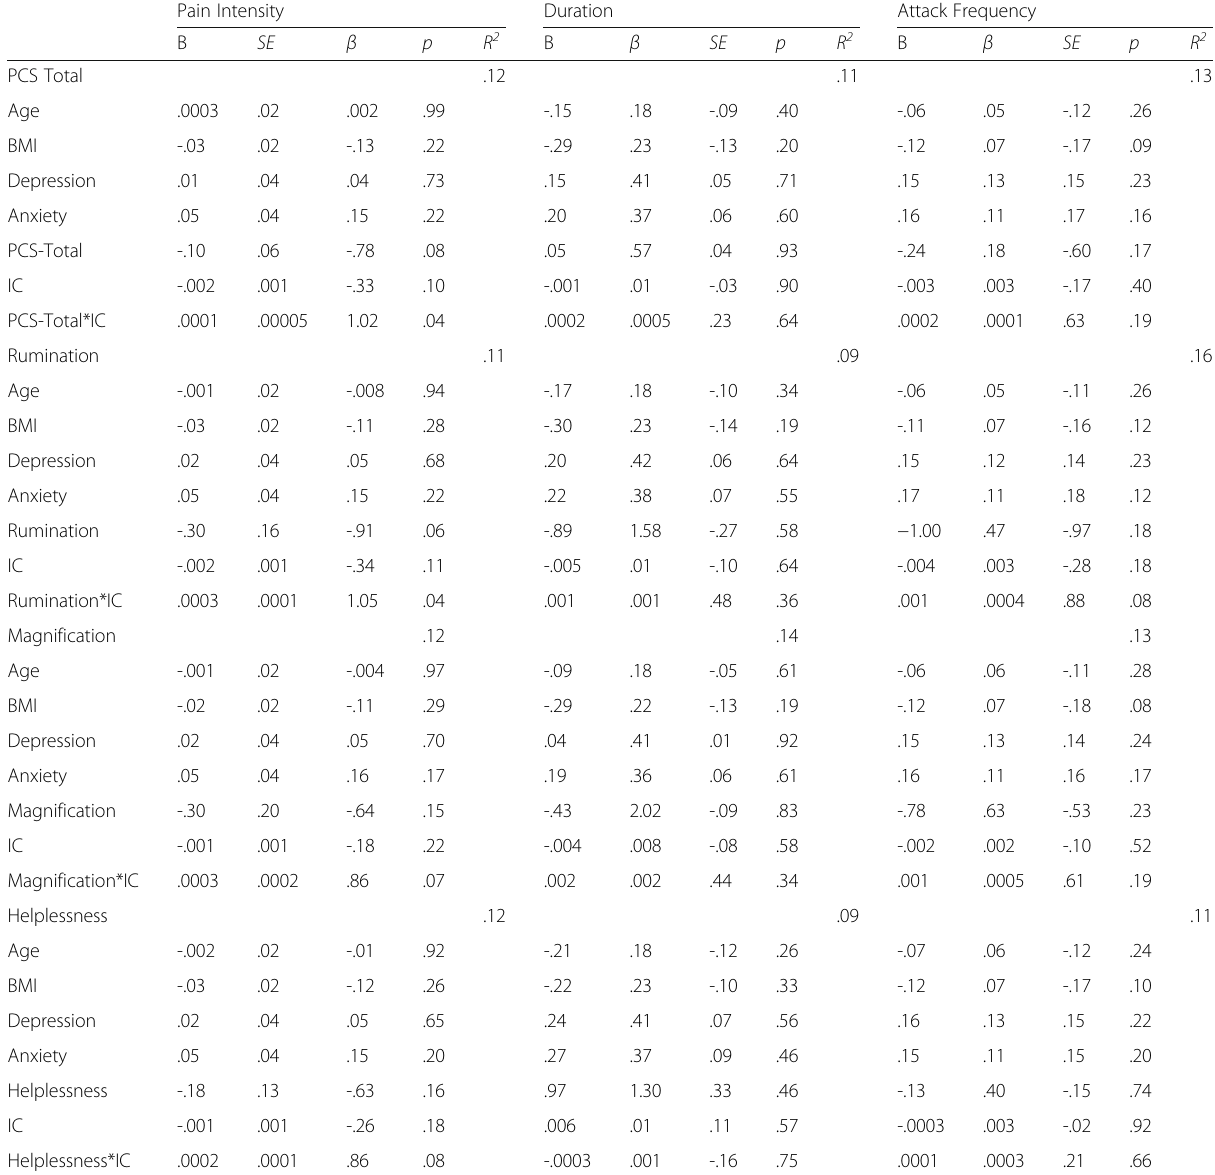
Table 2 Linear regressions examining pain catastrophizing, inhibitory control, and their interactions in relation to migraine severity as measured by attack frequency, pain intensity and duration Pain Intensity Duration Attack Frequency B SE β p R 2 B β